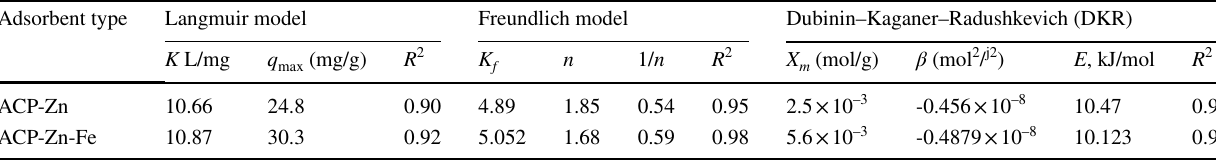
Table 5 Isotherm models parameters for chromium ions removal using ACP-Znand ACP-Zn-Fe